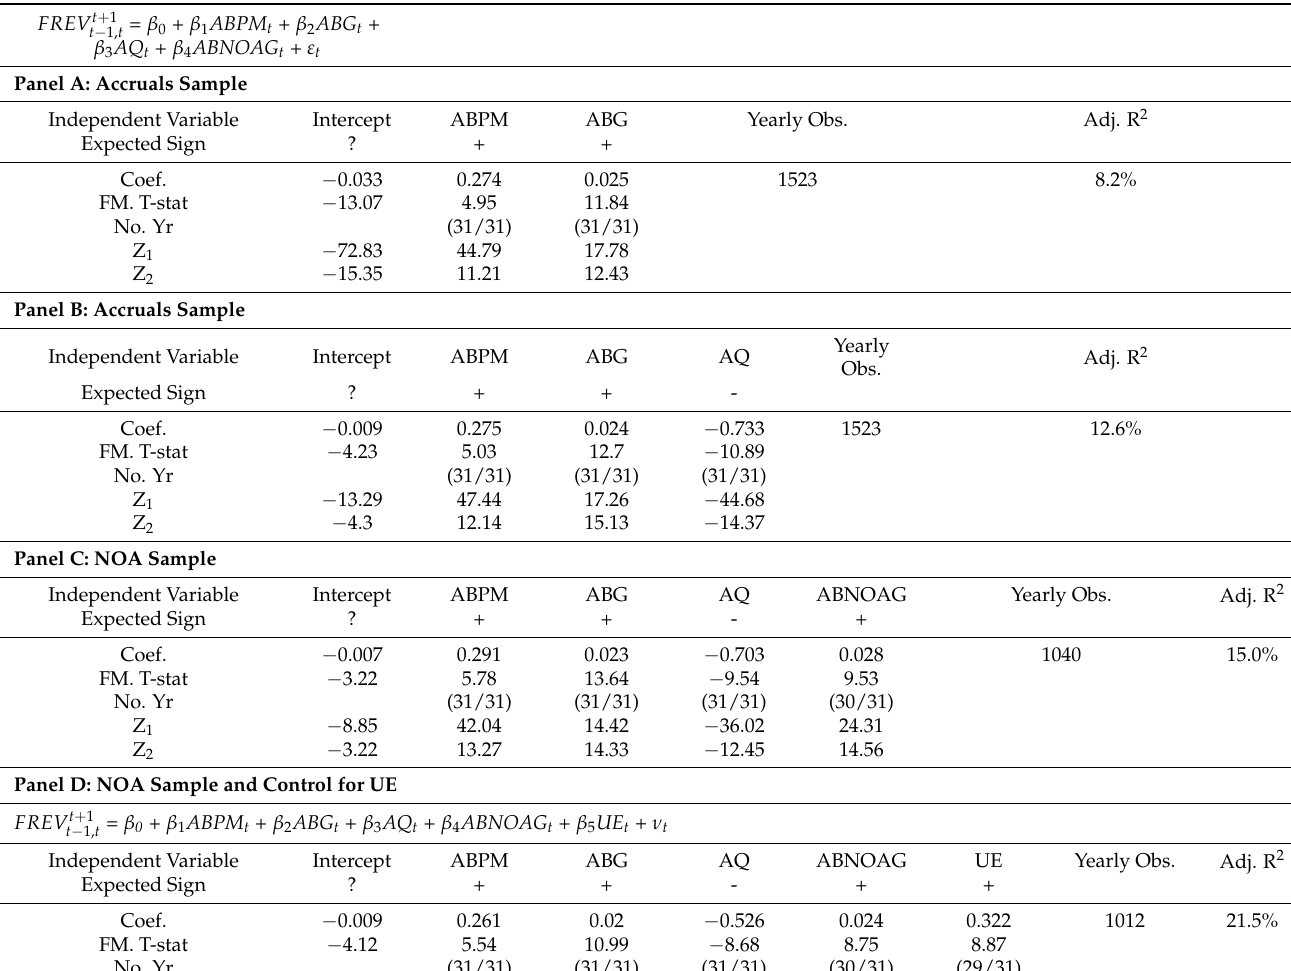
Table 4. Results of the regression of forecast revision results (the dependent variable is forecast